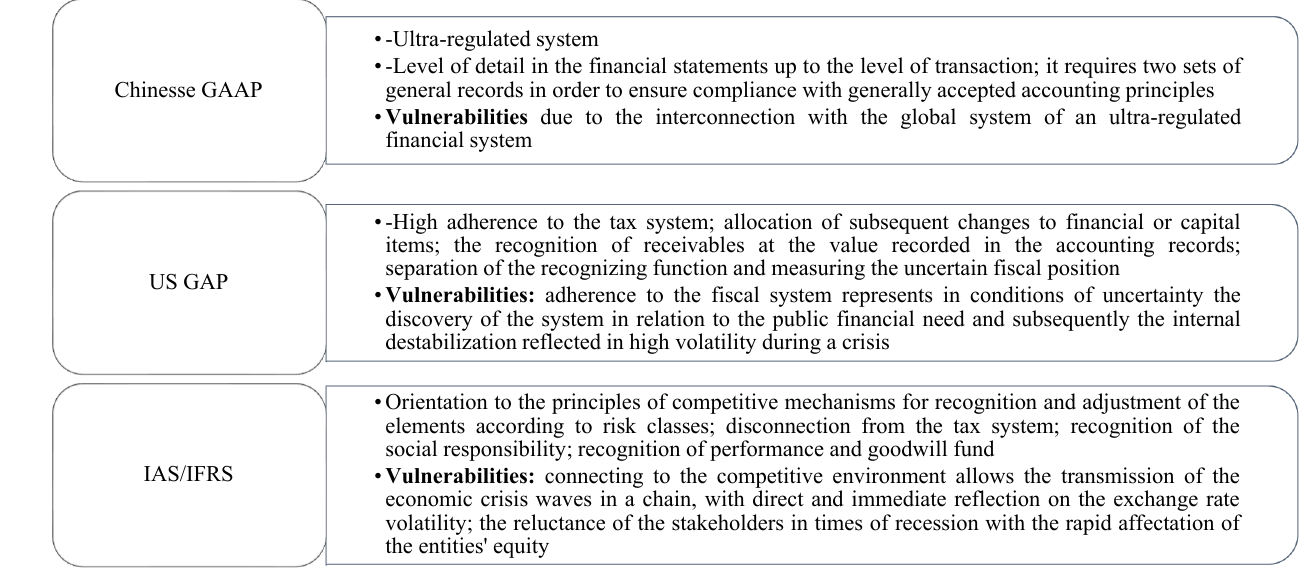
Figure 8. Diagram of the vulnerabilities regarding international accounting regulations. Source: Authors’ contribution